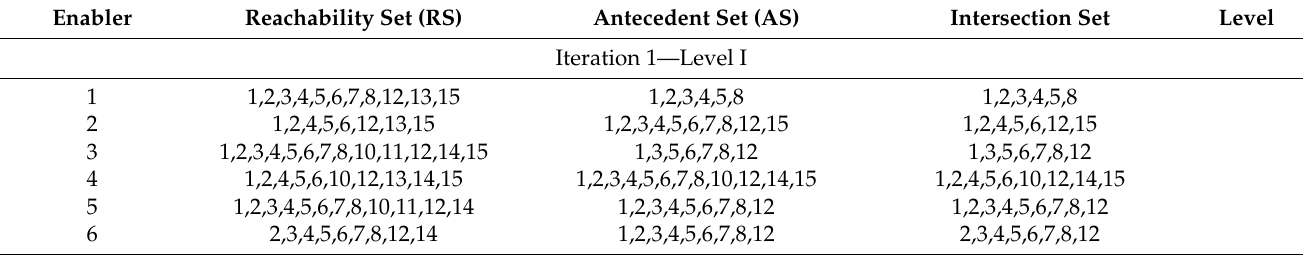
Table 7. Hierarchy levels of each